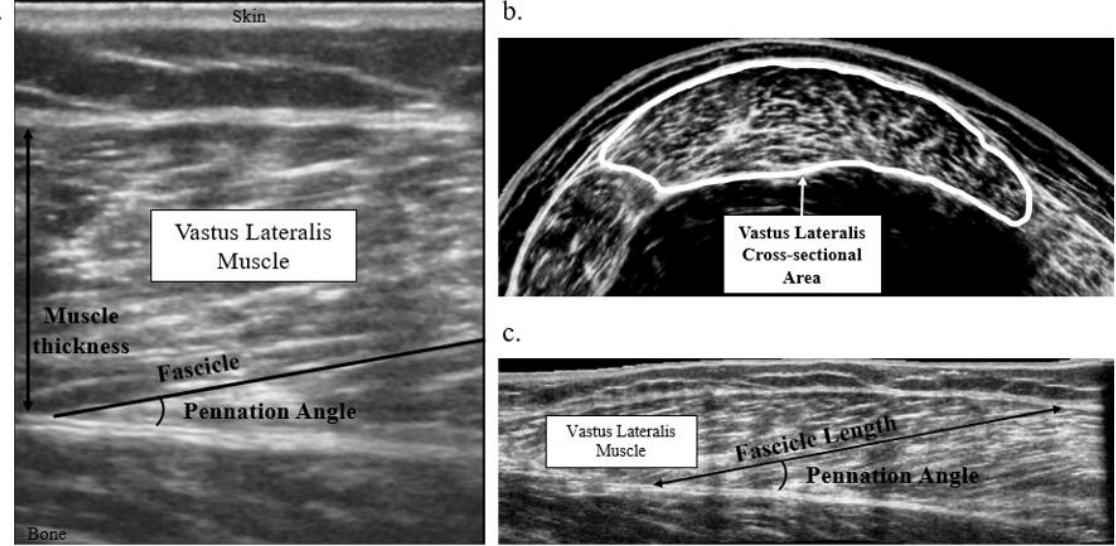
Figure 1. Ultrasonography images of the vastus lateralis muscle. ( a ) static long-axis image identifying muscle thickness, fascicle, and pennation angle; ( b ) extended-field-of-view short axis image identifying muscle anatomical cross-sectional area; ( c ) extended-field-of-view long axis image identifying fascicle length and pennation angle.